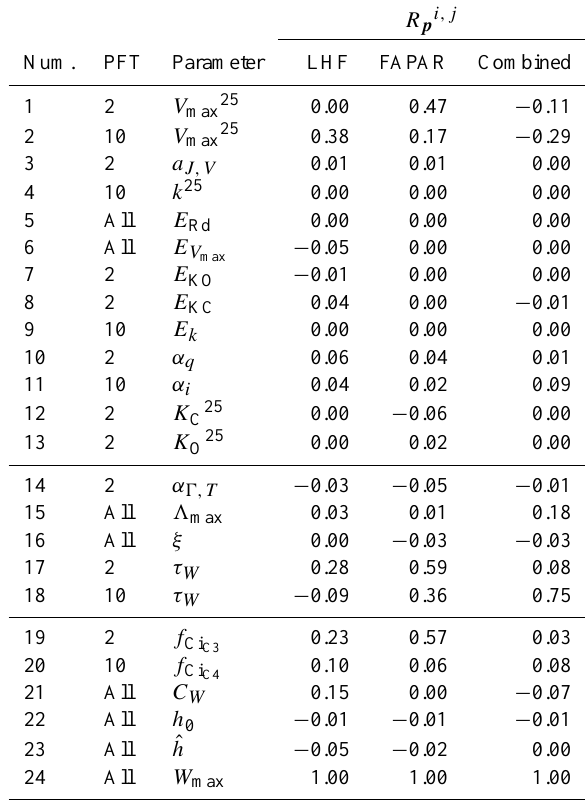
Table 3. Error correlation coefficient of W max to each model pa- rameter under optimization